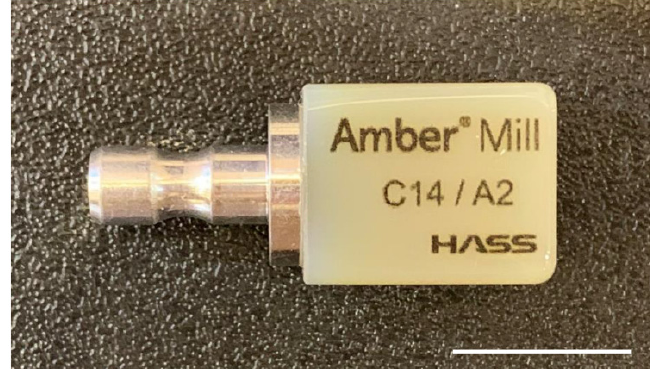
Figure 5. A bar-shaped lithium disilicate block (Amber Mill, HASS Co., Gangneung, Korea). This rectangular block is 14 mm in height, and is available for single restorations. Bar = 1 cm.